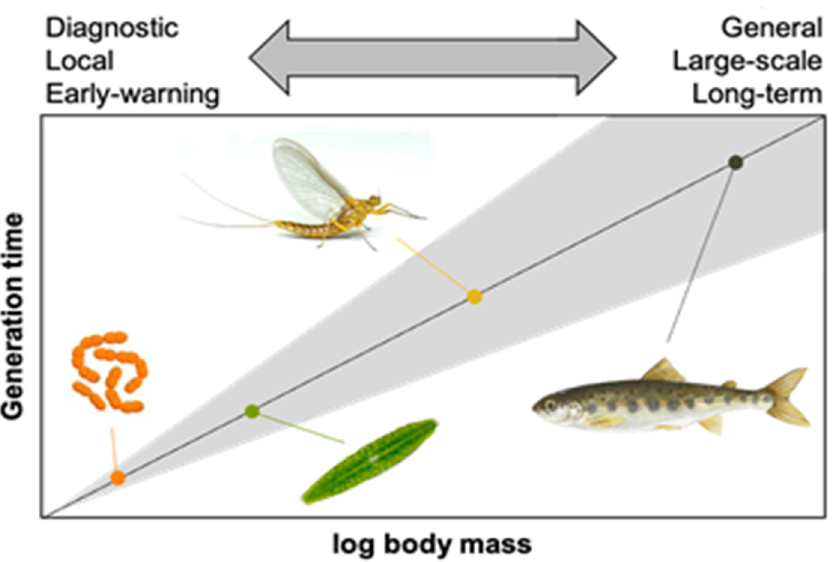
Figure 2. Capabilities in biological monitoring across the spectrum of body sizes. Relatively small- bodied, short-lived, and widely dispersed organisms such as microbes and diatoms can indicate short-term localised changes in the environment with potentially high specificity to particular stressors. On the other hand, larger-bodied, long-lived organisms such as macroinvertebrates and fish can be indicative of larger-scale longer-term environmental changes (from [55]).